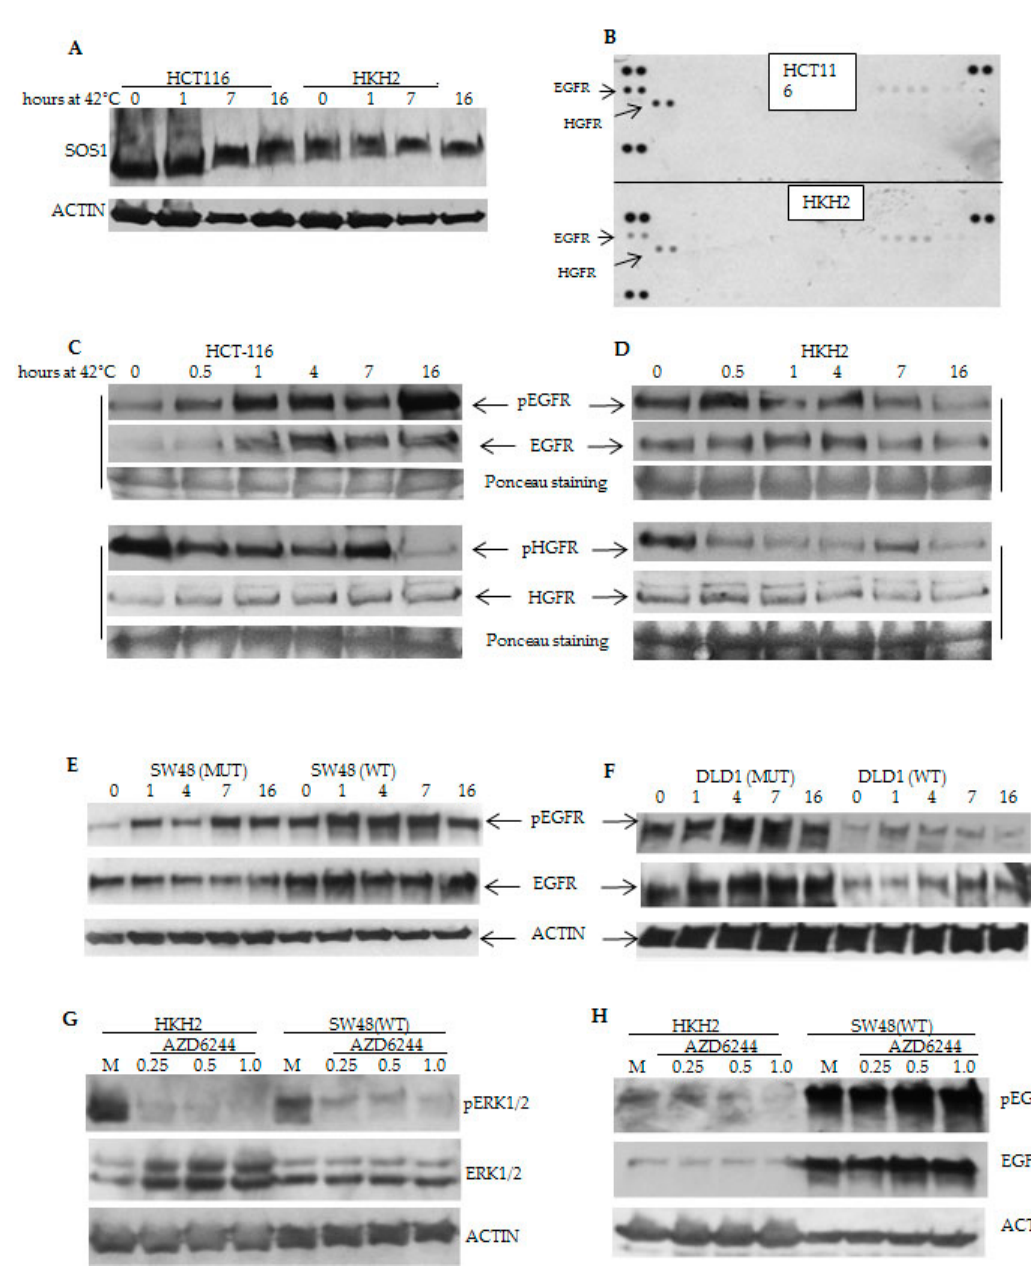
Figure 4. Hyperthermia modulates differentially receptor tyrosine kinase activity in KRAS isogenic cells. ( A – H ) Representative Western blot analyses with total cell lysates after incubations at 42 °C for up to 16 h (except for ( G ) and ( H ), when cells were exposed to treatments for 16 h). Antibodies are described in Materials and Methods. (A) The phosphorylation of SOS1 was detected by its delayed electrophoretic mobility on SDS ‐ PAGE gel [25,26]; ( B ) Analyses of the activation of RTKs after 16 ‐ hour incubations at 42 °C were performed with the Proteome Profiler human phospho ‐ RTK array (R&D Systems).